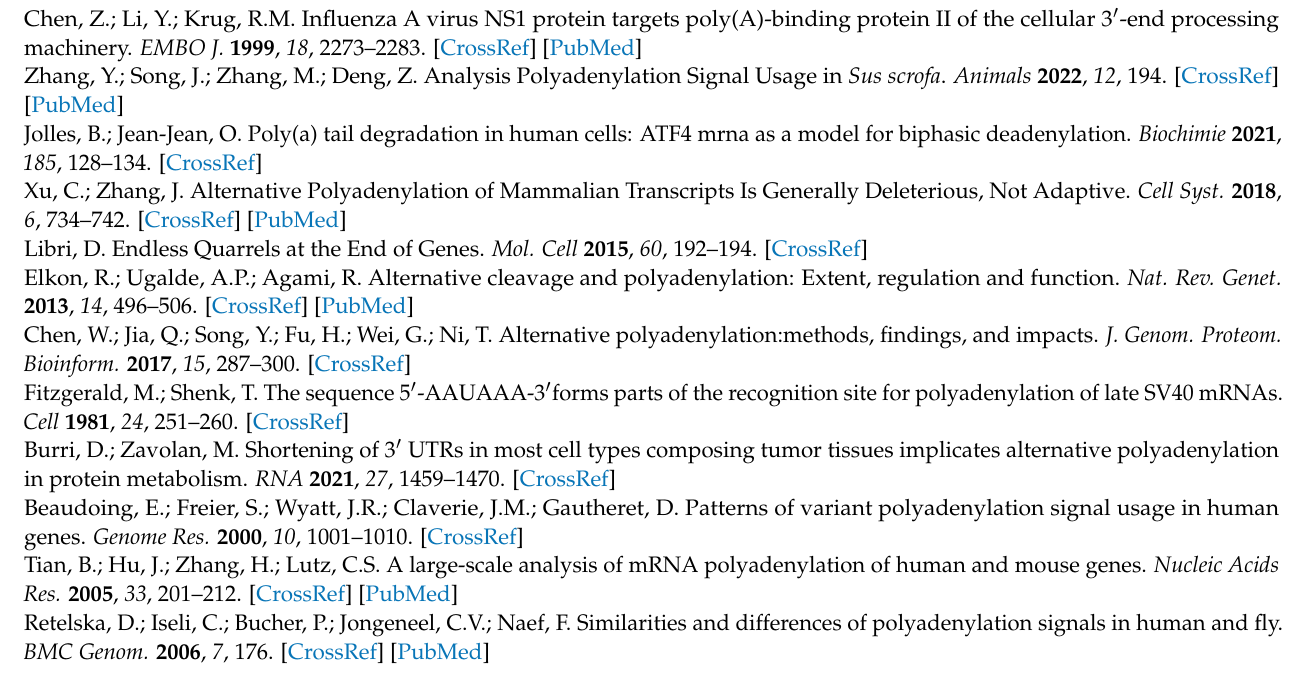
extract the polyA transcript. Figure S1: Sequence characterization around the cleavage site. Figure S2: The genes with 1 polyadenylation signals were applied for GO annotation and enrichment. Figure S3: The genes with 3 or more polyadenylation signals were applied for GO annotation and